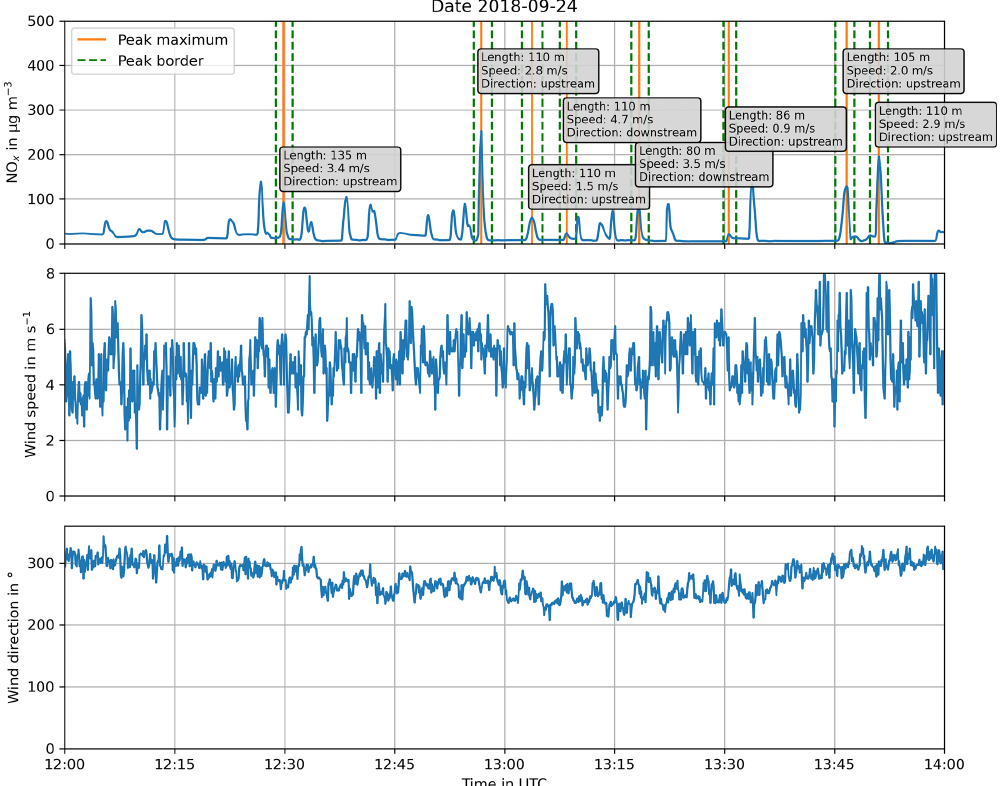
Figure 2. Example of the measured NO x concentration, wind speed, and wind direction at DURH (5s time resolution). Ship peaks identified in the NO x concentration are marked with an orange line, and their borders are dashed green lines. The text box at each peak shows the ship length (in m), the speed over ground (in ms − 1 ), and the direction of travel (upstream or downstream). Peaks without a label are most likely also caused by passing ships. In these cases, an unambiguous assignment of a source was not